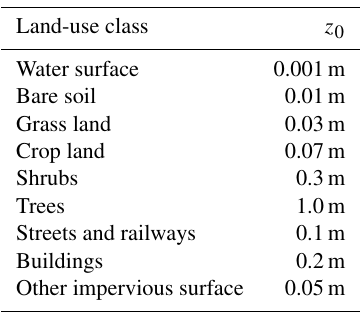
Table 2. Roughness length values z 0 of the different land-cover classes used in all CAIRDIO